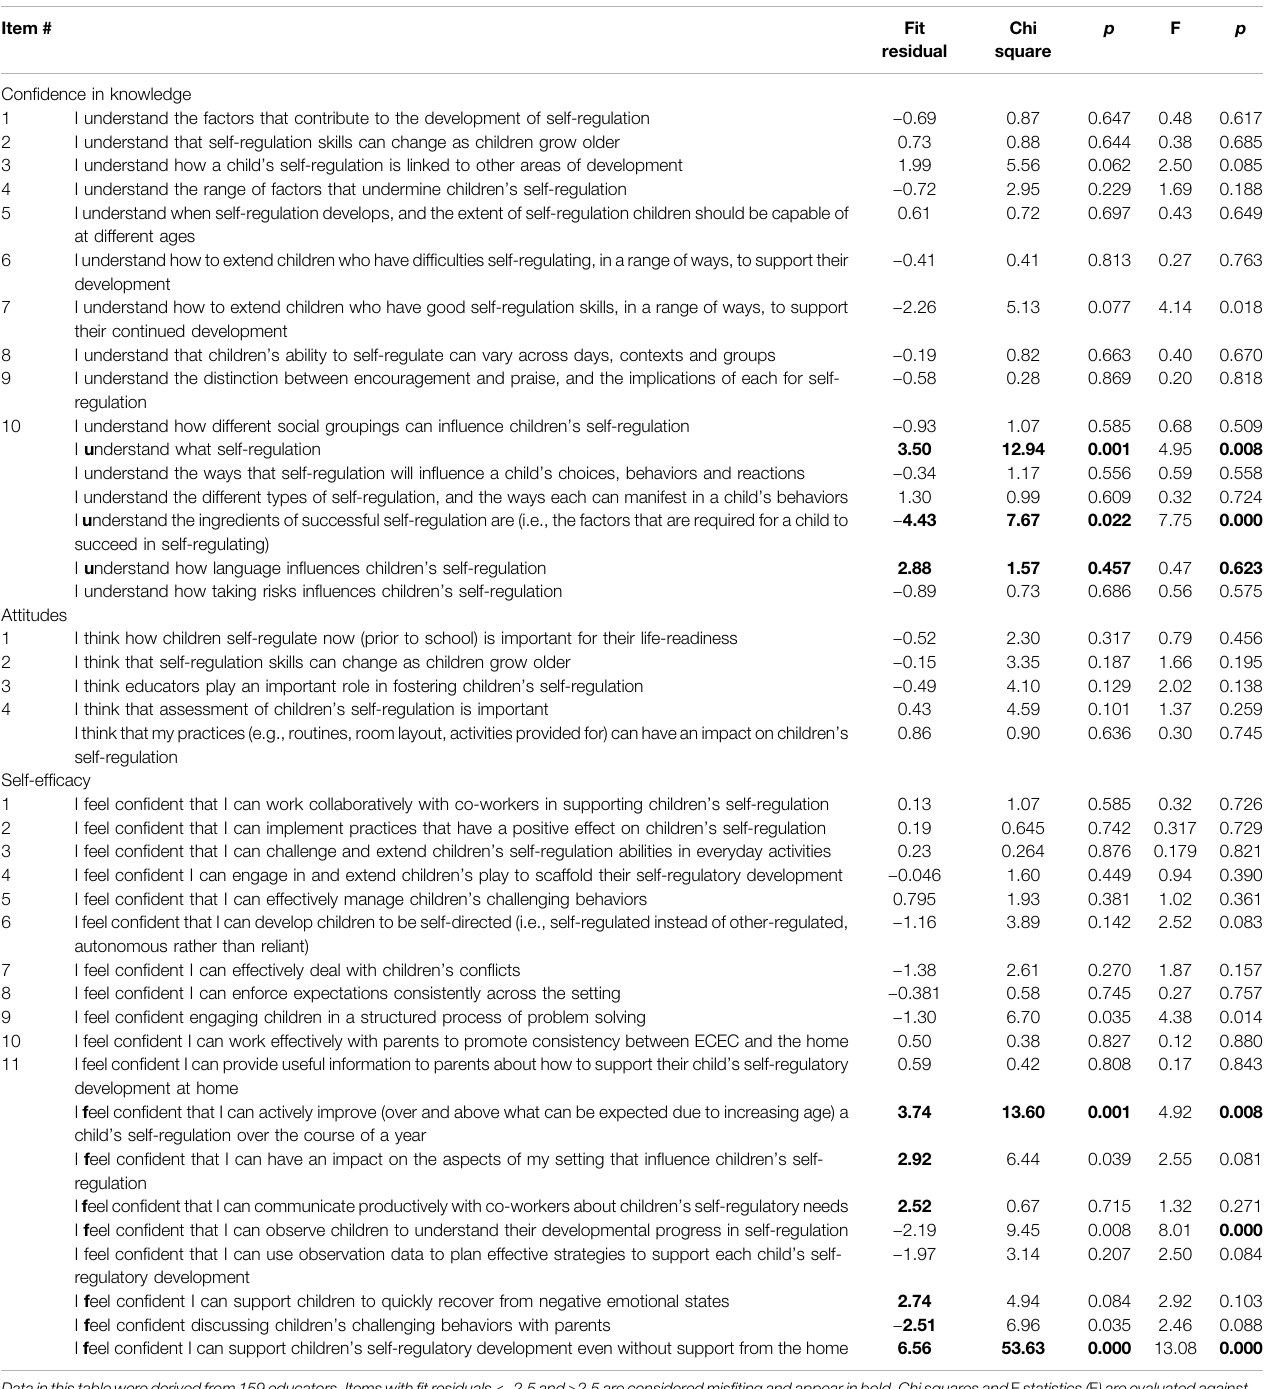
TABLE 3 | Individual item fi t of the three